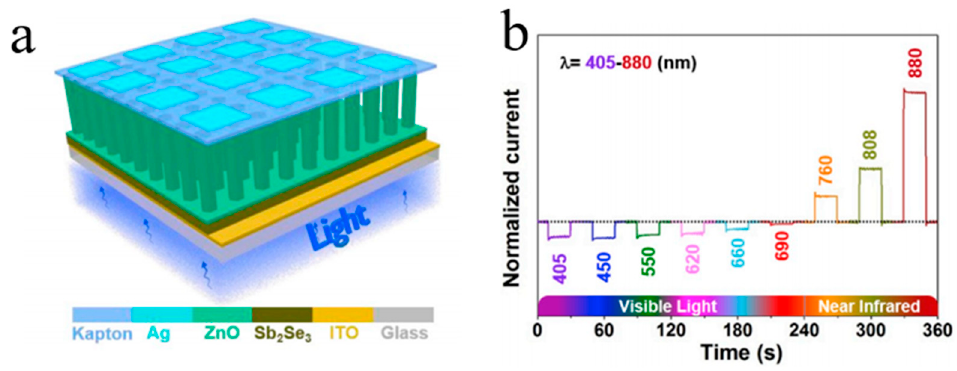
Figure 1. ( a ) Schematic view of the photodetector and ( b ) normalized photocurrent under illumi- nation of light with different wavelengths [49].